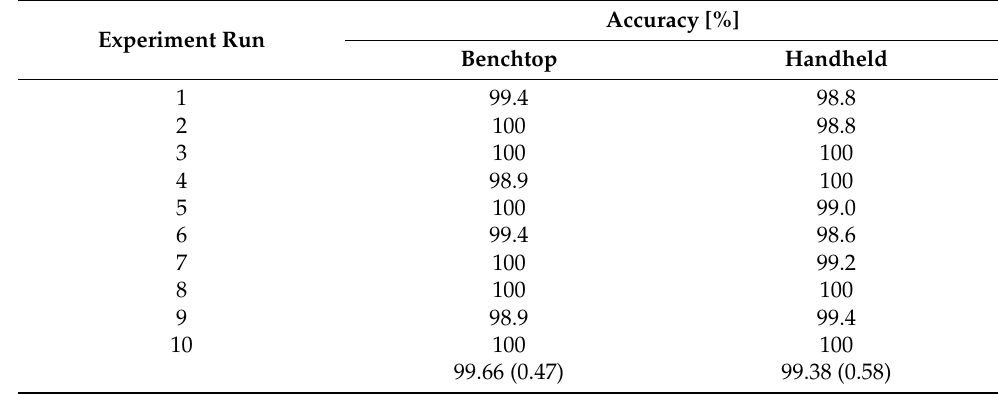
Table A7. Result of detecting imitation vanilla (vanillin) among real vanilla extracts. The table reports 10 independent 5 × 2 cross-validation